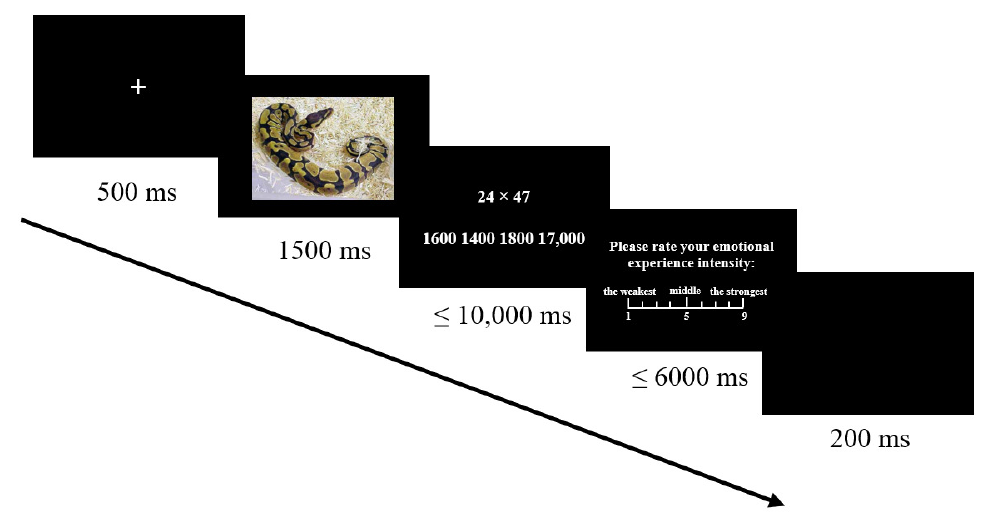
Figure 1. Flow chart of experiment